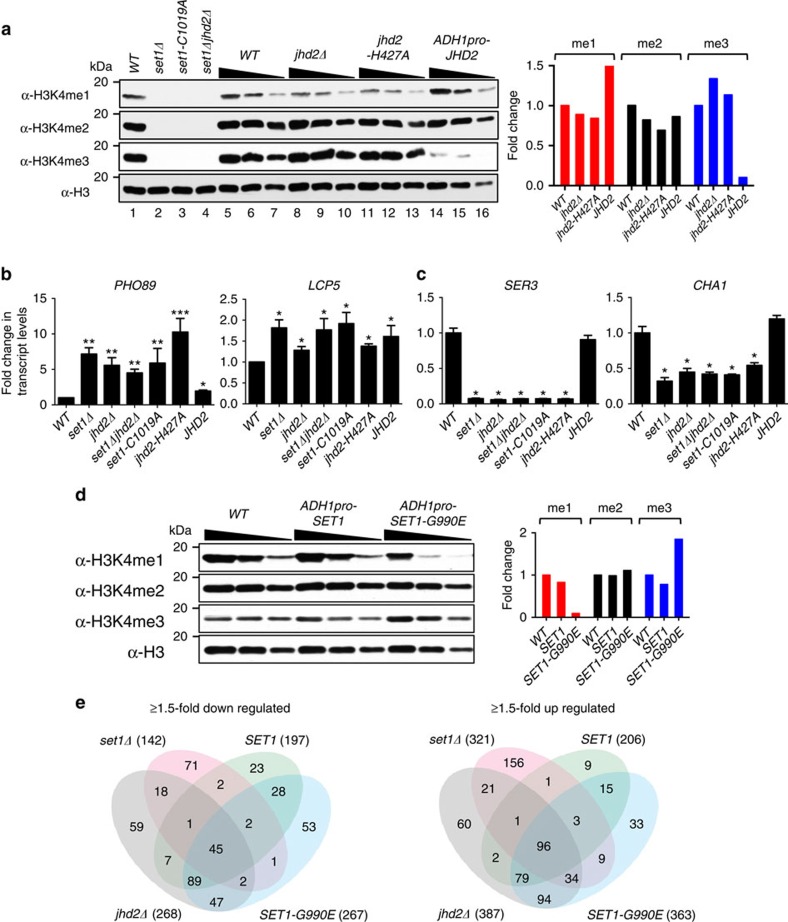
Transcriptional co-regulation is dependent on Set1 and Jhd2 catalytic activities and H3K4 methylation.(a) Western blots for H3K4me1, H3K4me2 and H3K4me3 in WT, deletion mutants (set1Δ, jhd2Δ and set1Δ jhd2Δ), catalytic-dead mutants (set1-C1019A and jhd2-H427A) and Jhd2 overexpressing strain (ADH1pro-JHD2) are shown. Histone H3 serves as loading control. Twofold serial dilutions of cell extracts from the indicated strains were applied in lanes 5–16. Graph shows quantitation of western blots using densitometry. Fold-change in a H3K4 methyl mark level normalized to the total H3 level in a mutant is shown relative to that in control WT (set as 1). (b) Fold-change in PHO89 and LCP5 sense transcript levels in the indicated mutants relative to WT are shown. For (b,c), error bars denote ±s.e.m. from four independent experiments (n=4). Statistical significance calculated using the Student's t-test. PHO89: *P-value <0.05, **P-value <0.005, ***P-value <10−5; LCP5: *P-value ≤0.005. (c) Fold-change in SER3 and CHA1 transcript levels in the indicated mutants relative to WT are shown. SER3: *P-value <10−5, CHA1: *P-value <10−3. (d) Western blots for bulk H3K4 methylation and H3 levels in WT strain or strains overexpressing SET1 or hyperactive SET1-G990E. Graph shows quantitation of western blots using densitometry. (e) Four-way Venn diagrams showing the number of shared up- or down-regulated sense transcripts in each combination of indicated deletion or overexpression mutant strains. The total number of up- or down-regulated transcripts in each mutant is indicated in parentheses. For (a–d), see Supplementary Figs 20 and 21 for full-length image of blots.